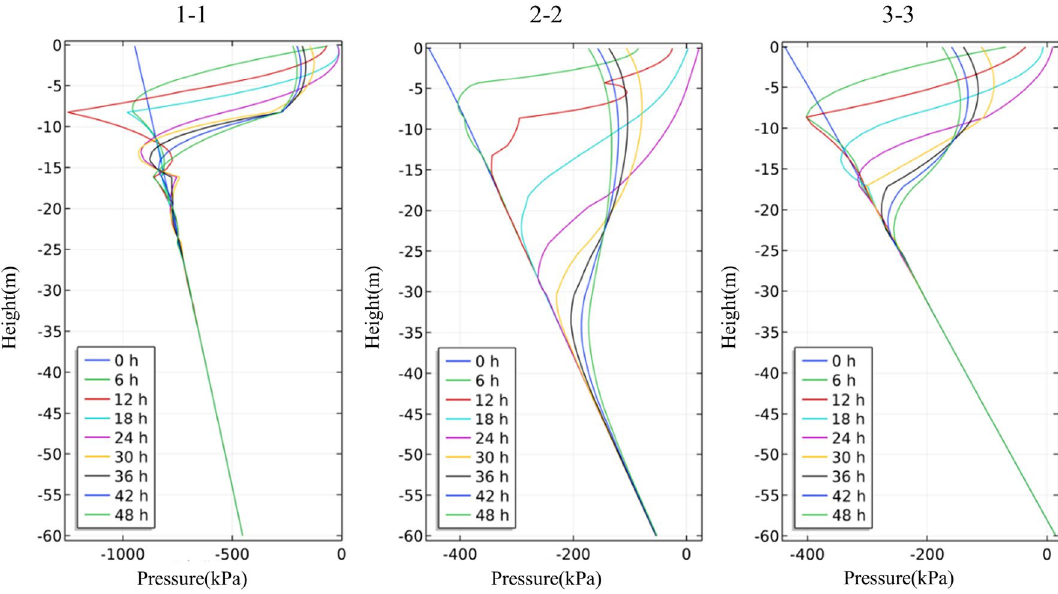
Figure 18. The variation of pore-water pressure in characteristic profiles (Scheme